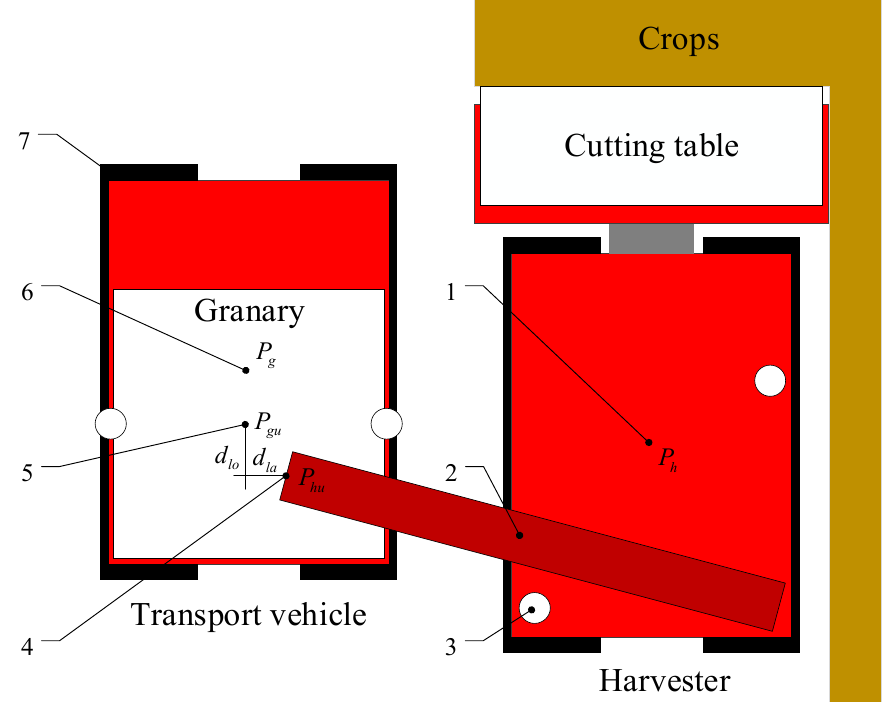
Figure 1. Schematic diagram of a collaborative harvest unloading operation. 1. Harvester positioning point. 2. Grain unloading barrel. 3. GNSS receiving antenna. 4. Grain unloading port. 5. Grain unloading target point. 6. Transport vehicle positioning point. 7. Pedrail. Note: P h is the satellite